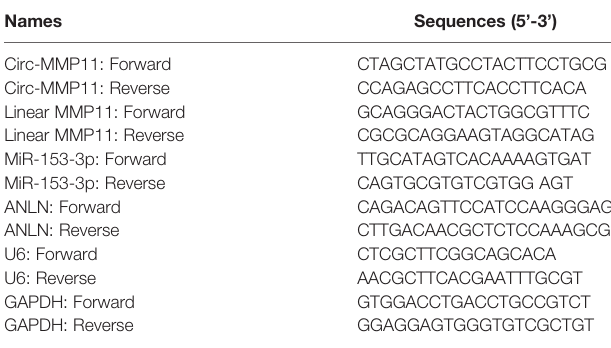
TABLE 1 | The sequences of primers for RT − qPCR used in this